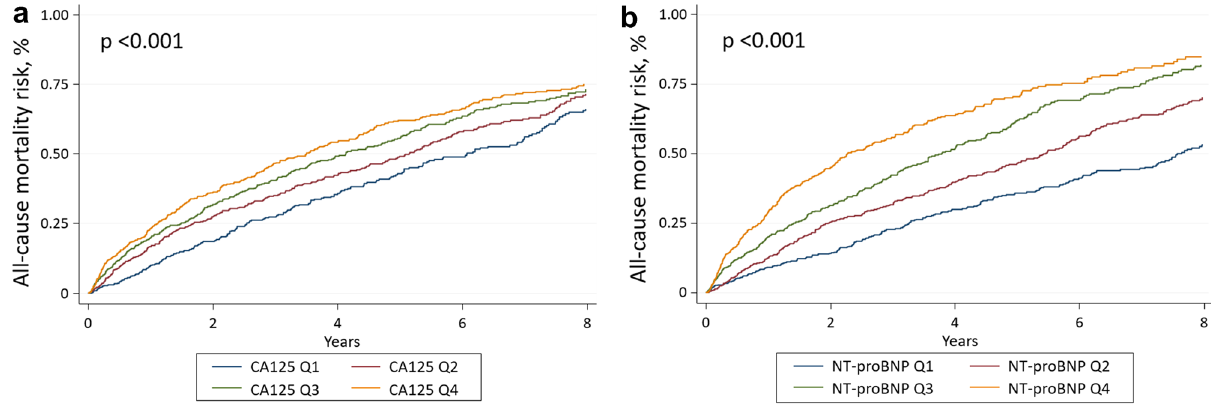
Figure 3. All-cause mortality risk across CA125 and NT-proBNP quartiles. ( a ) CA125 quartiles. ( b ) NT-proBNP quartiles. CA125: carbohydrate antigen 125; NT-proBNP: amino-terminal pro-brain natriuretic peptide. CA125 quartiles: Q1 = 1.4–19 U/mL; Q2 = 19–38.26 U/mL; Q3 = 38.3–90 U/mL; Q4 = 90–1500 U/ mL. NT-proBNP quartiles: Q1 = 24–1589 pg/mL; Q2 = 1590–2922 pg/mL; Q3 = 2924–5447 pg/mL; Q4 = 5450– 35,000